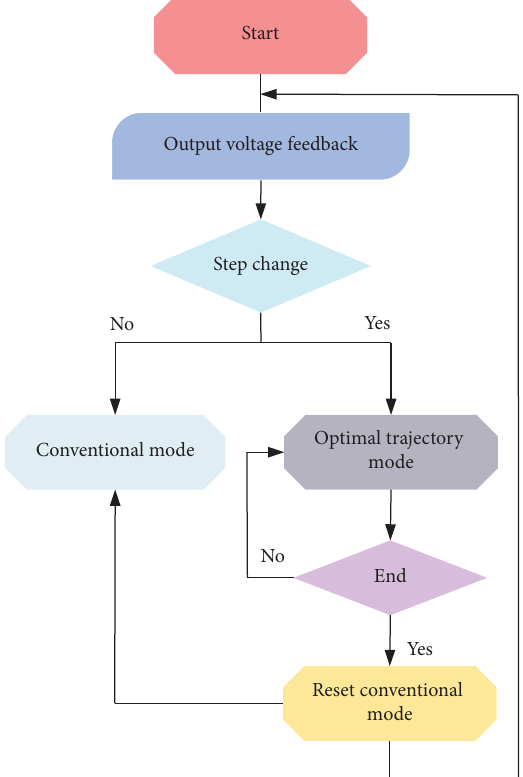
Figure 7: Flow chart of the on-line optimal trajectory control algorithm under the diferent load step